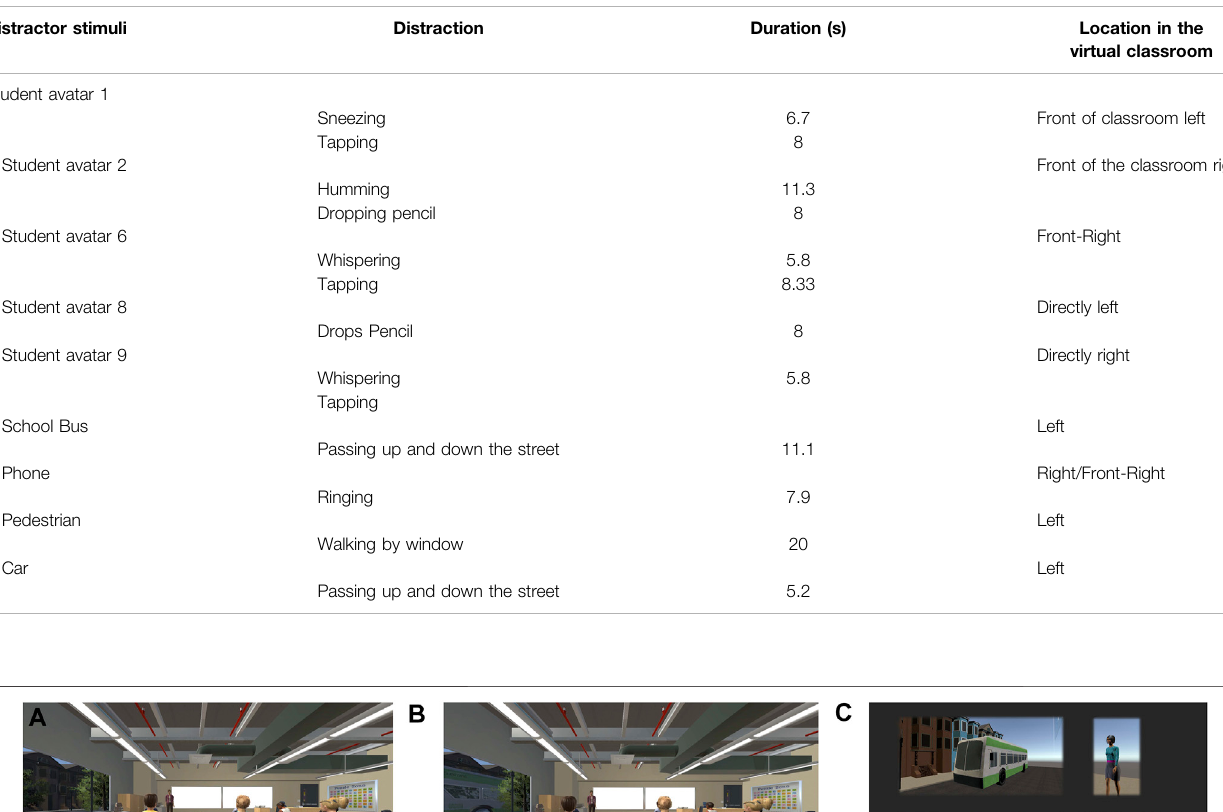
TABLE 2 | Distractors.